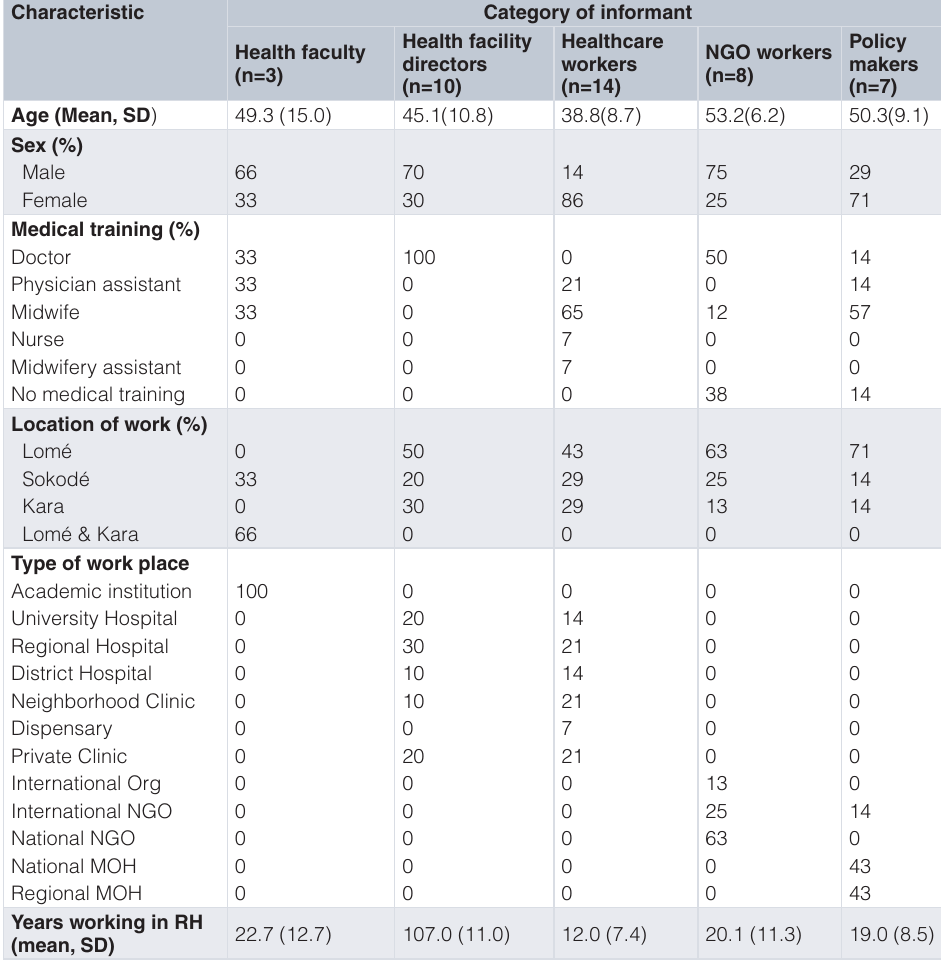
Table 3. Characteristics of key